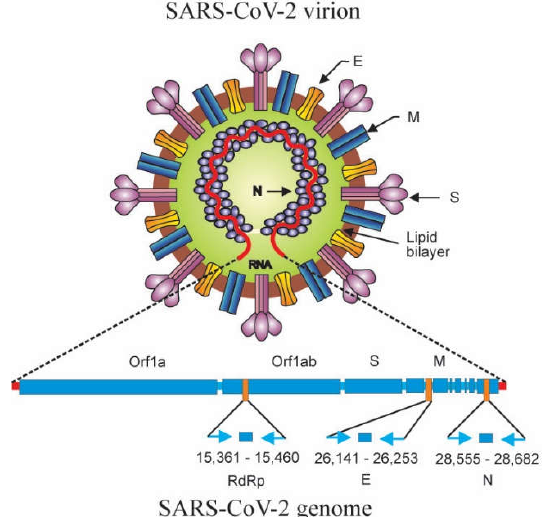
Figure 7. Schematic diagram of molecular structure, genome organization, and relative positions of amplicon targets on the SARS-CoV-2 genome. On the SARS-CoV-2 virion, together with membrane protein and envelope protein, the spike protein glycoprotein projects from a lipid bilayer, giving the virion a distinctive appearance. SARS-CoV-2 virion (top): M: membrane protein; E: envelope protein; S: spike protein; N: nucleocapsid protein. The SARS-CoV-2 genomic RNA is associated with the nucleocapsid protein forming the ribonucleoprotein with a helical structure. The SARS-CoV-2 genome encodes structural (S, M, E, N) and nonstructural proteins. The relative positions of amplicon targets (RdRp, E, N) are shown. SARS-CoV-2 genome (bottom): Orf1a: open reading frame 1a; Orf1ab: open reading frame 1ab; S: spike protein gene; M: membrane protein gene; RdRp: RNA-dependent RNA polymerase gene; E: envelope protein gene; N: nucleocapsid protein gene (adapted from Corman et al. [3]; Artika et al. [55]).